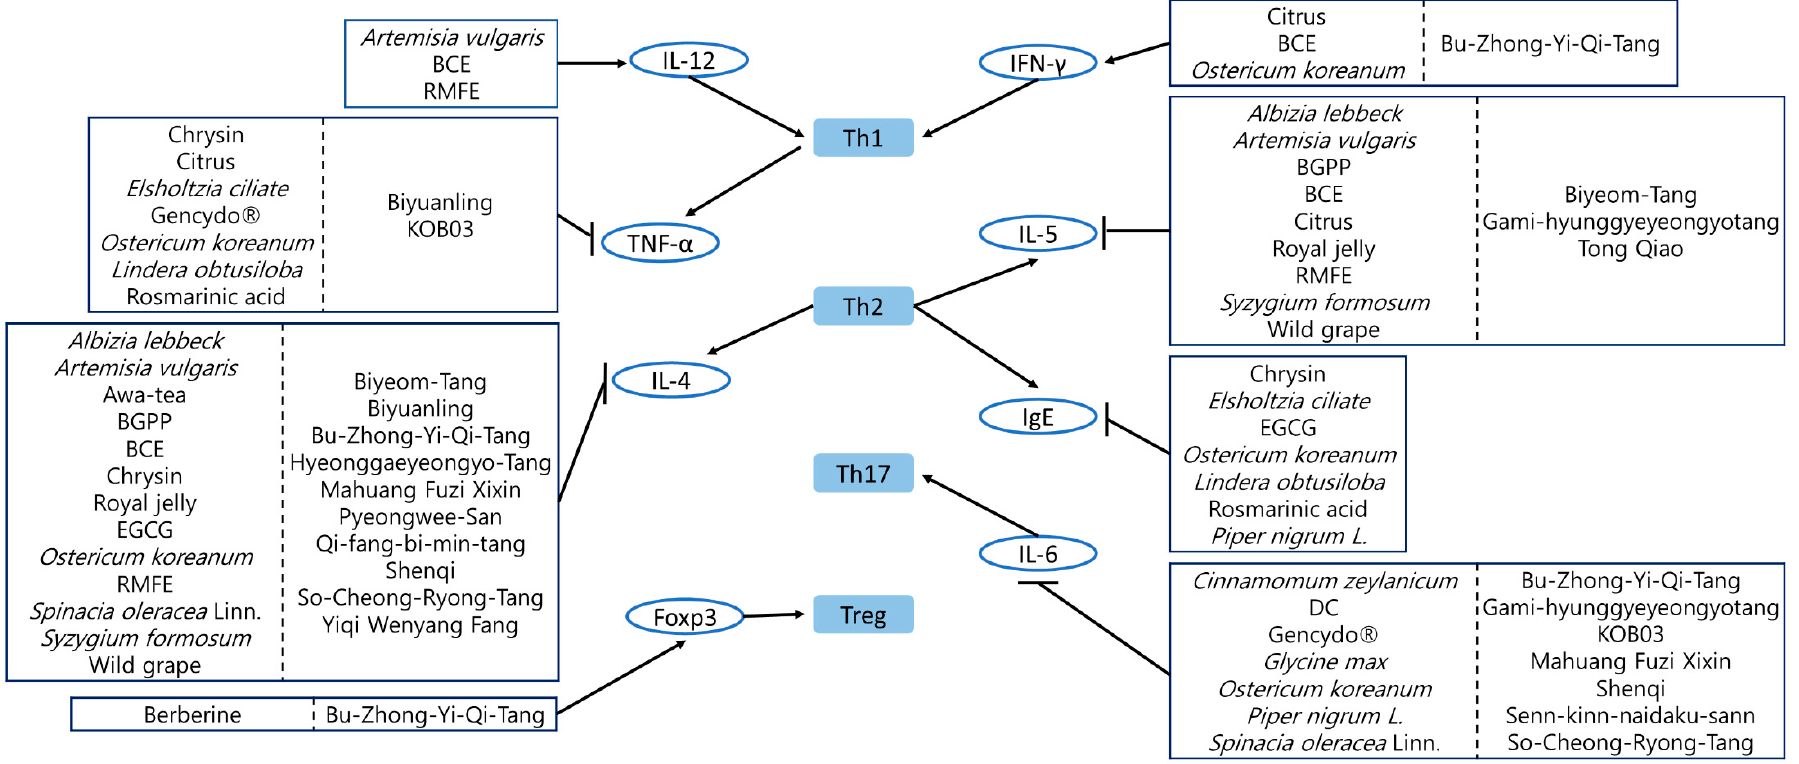
Figure 2. Schematic diagram of plants and decoctions that ameliorated allergic rhinitis by triggering T helper cell differentiation; BCE, Bupleurum chinense water extract; RMFE, Rosae Multiflorae Fructus water extract; BGPP, Brazilian green propolis; EGCG, Epigallocatechin gallate; DC, Dryopteris crassirhizoma.